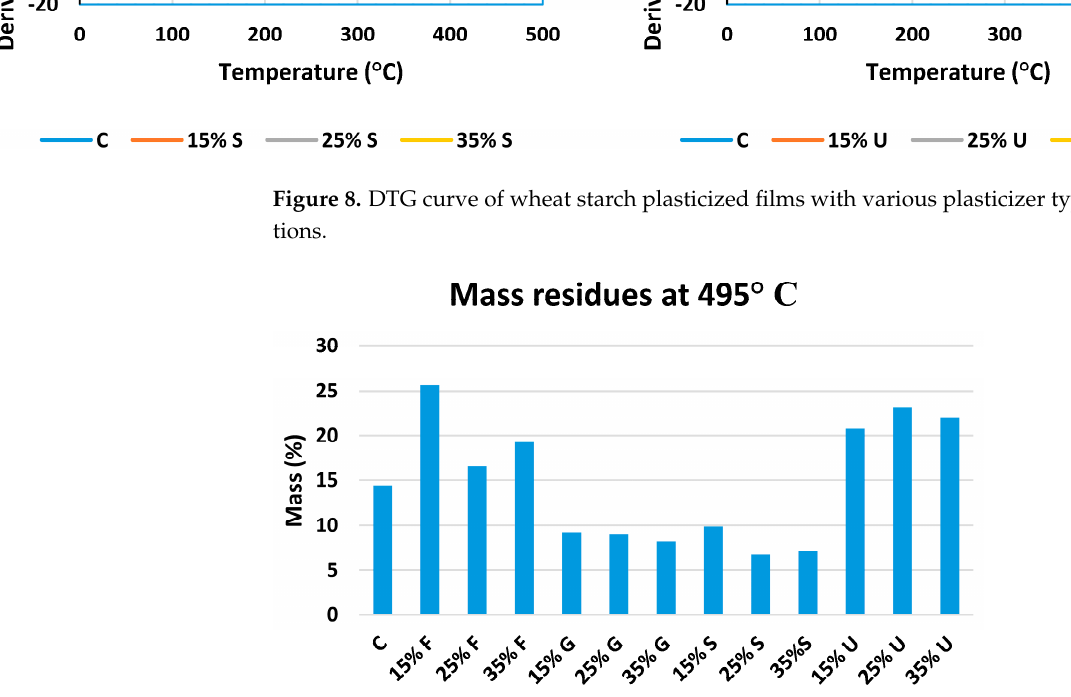
Figure 9. Mass residues of plasticized wheat starch films at 495 °C.